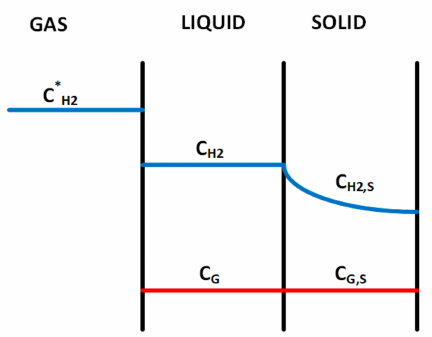
Figure 3. Concentration profiles in each phase of the